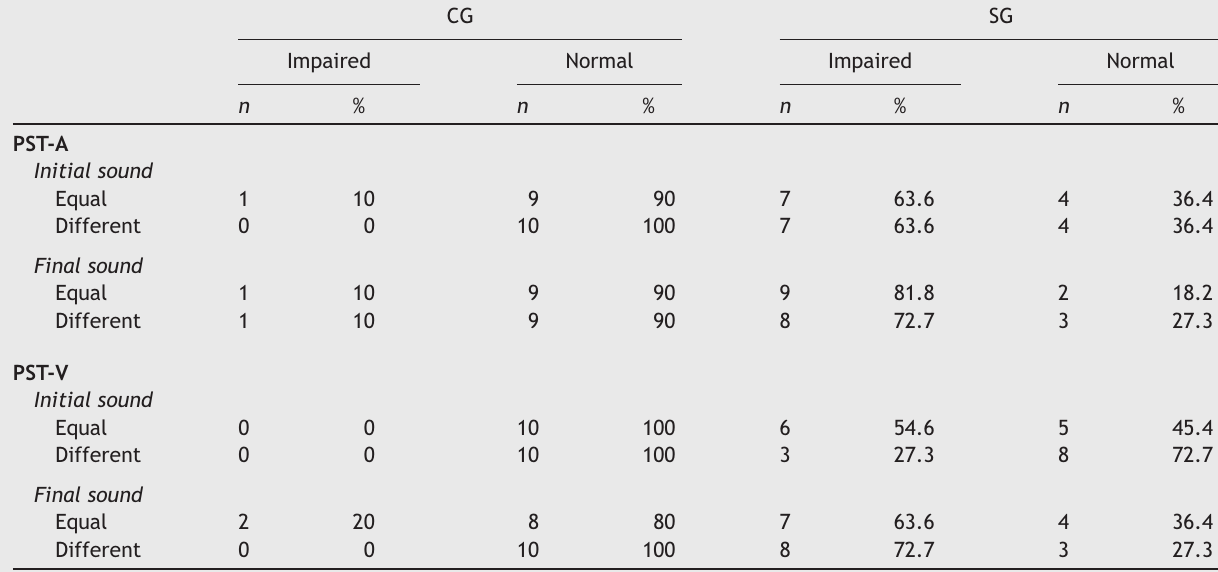
Table 4 Frequency distributions and percentages of Phonological Sensitivity Test-Auditory (PST-A) and Phonological Sensitivity Test-Visual (PST-V) in the control group (CG) and study group